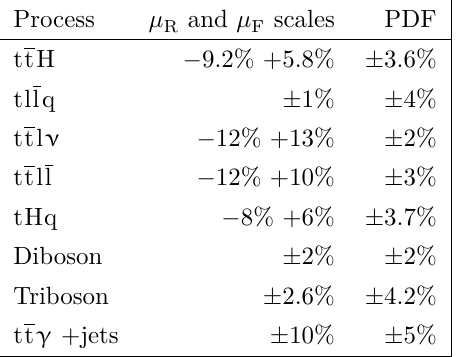
Table 3 . Cross section (rate) uncertainties used for the fit. Each column in the table is an inde- pendent source of uncertainty. Uncertainties in the same column for different processes (different rows) are fully